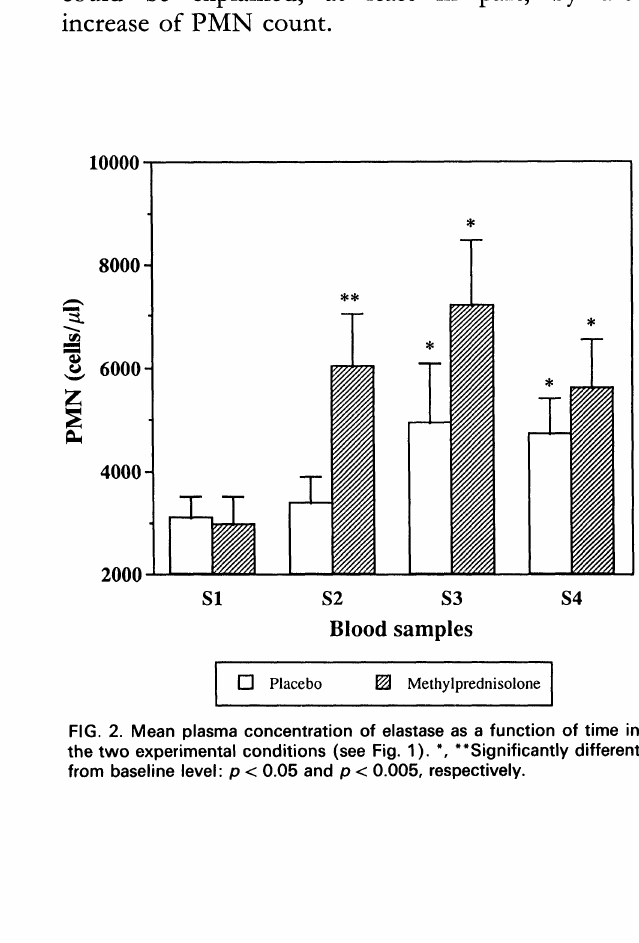
FIG. 2. Mean plasma concentration of elastase as a function of time in the two experimental conditions (see Fig. 1). **Significantly different from baseline level" p < 0.05 and p < 0.005, respectively.